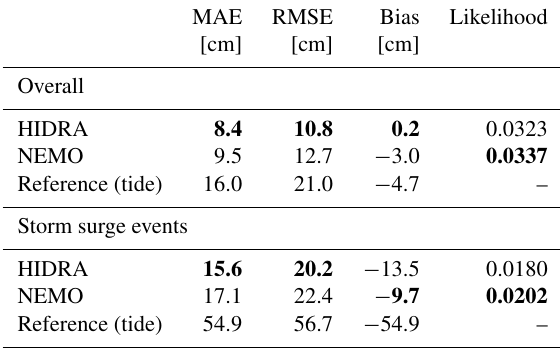
Table 8. Comparison of HIDRA and NEMO on the Koper 2019 test dataset. Overall performance is shown separately from performance during storm surge events. Performance of the astronomic tide is provided for reference. The best result in each category is denoted in bold.